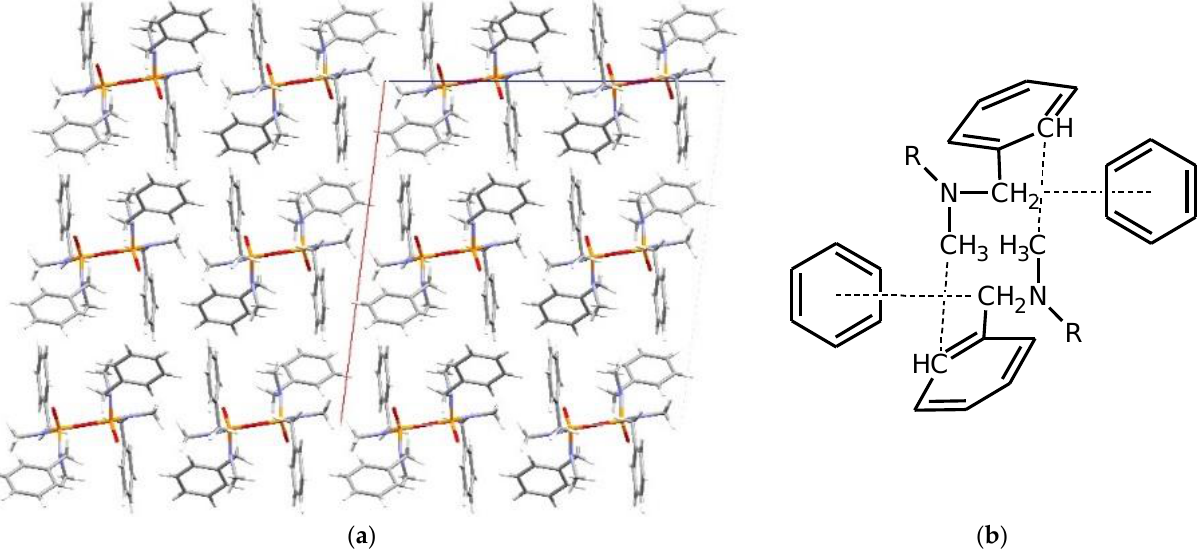
Figure 12. Packing of O((BzMeN) 2 PO) 2 : ( a ) C–H ··· Ph interactions which act as the main supramolecular building block (generated in Mercury [25]); ( b ) simplified diagram of the supramolecular motif (generated using ChemSketch [24]).